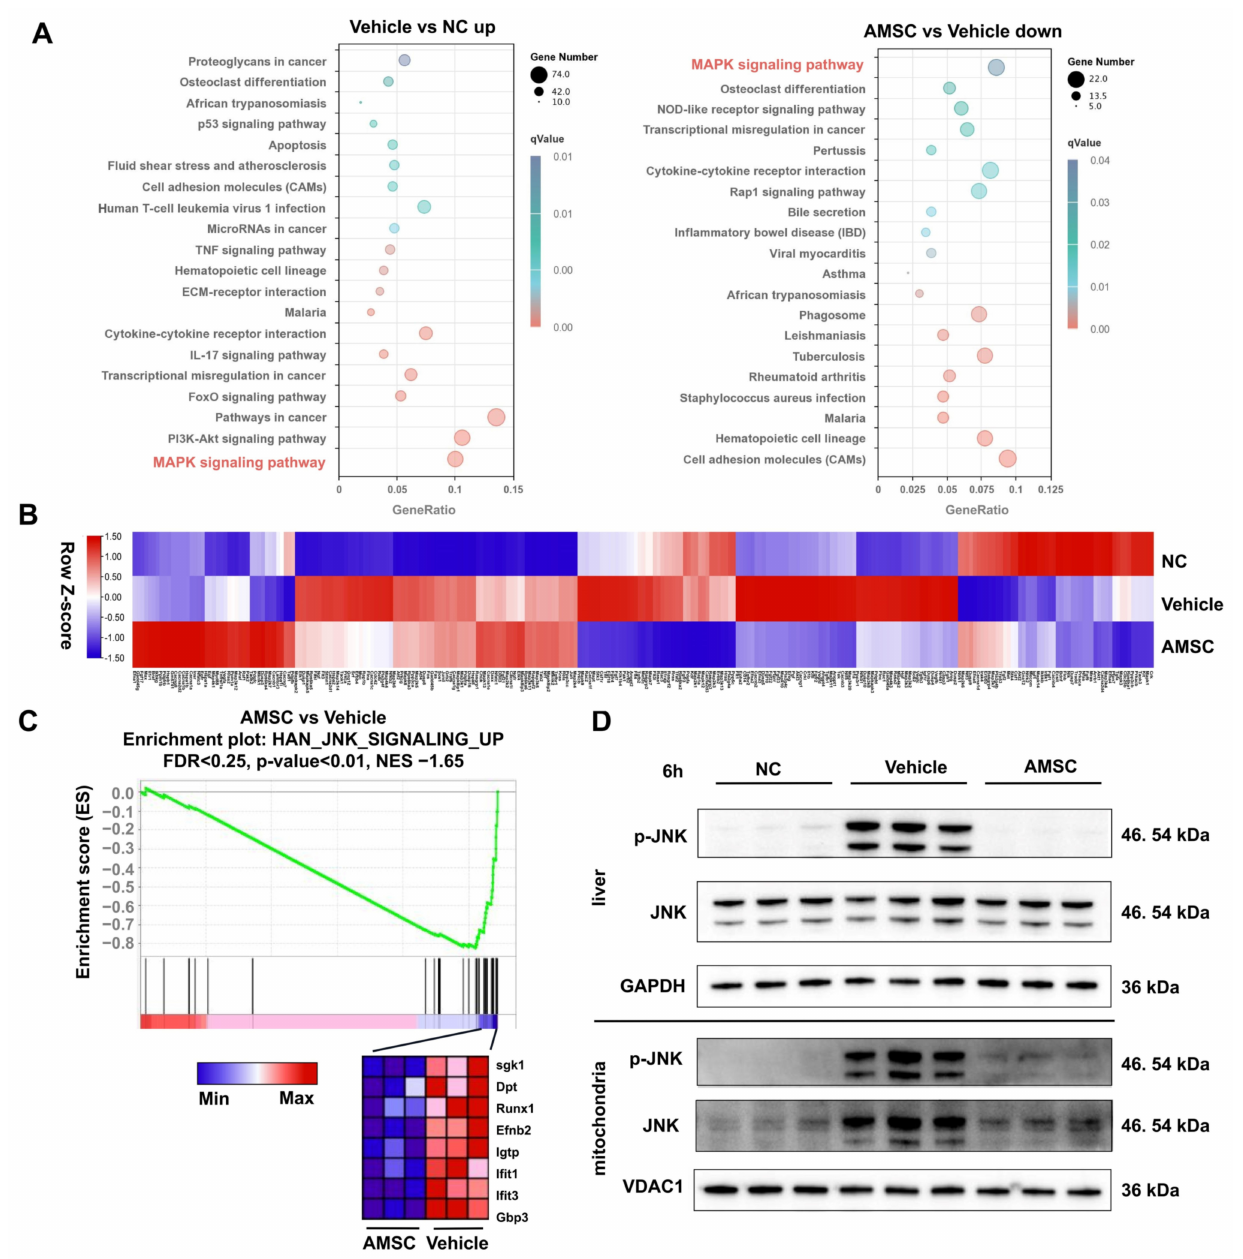
Figure 4. AMSCs inhibit JNK activation and mitochondrial translocation in AILI. ( A ) The enrichment maps of KEGG pathways of differentially expressed genes in the vehicle group versus the NC group and the AMSC group versus the vehicle group. ( B ) Heat maps of the MAPK signaling pathway gene subset in each group plotted with cohort means of Z scores. ( C ) The pathway of JNK signaling up was among significant differences in GSEA of AMSC group vs. vehicle group. Genes with the highest enrichment score are shown as a gene expression-based heat map. ( D ) The Western blot analysis of p-JNK level in isolated mitochondria and liver tissue after 6 h APAP exposure and AMSC treatment. NC group: normal control mice; vehicle group: APAP-overdosed mice; AMSC group: AMSC-treated